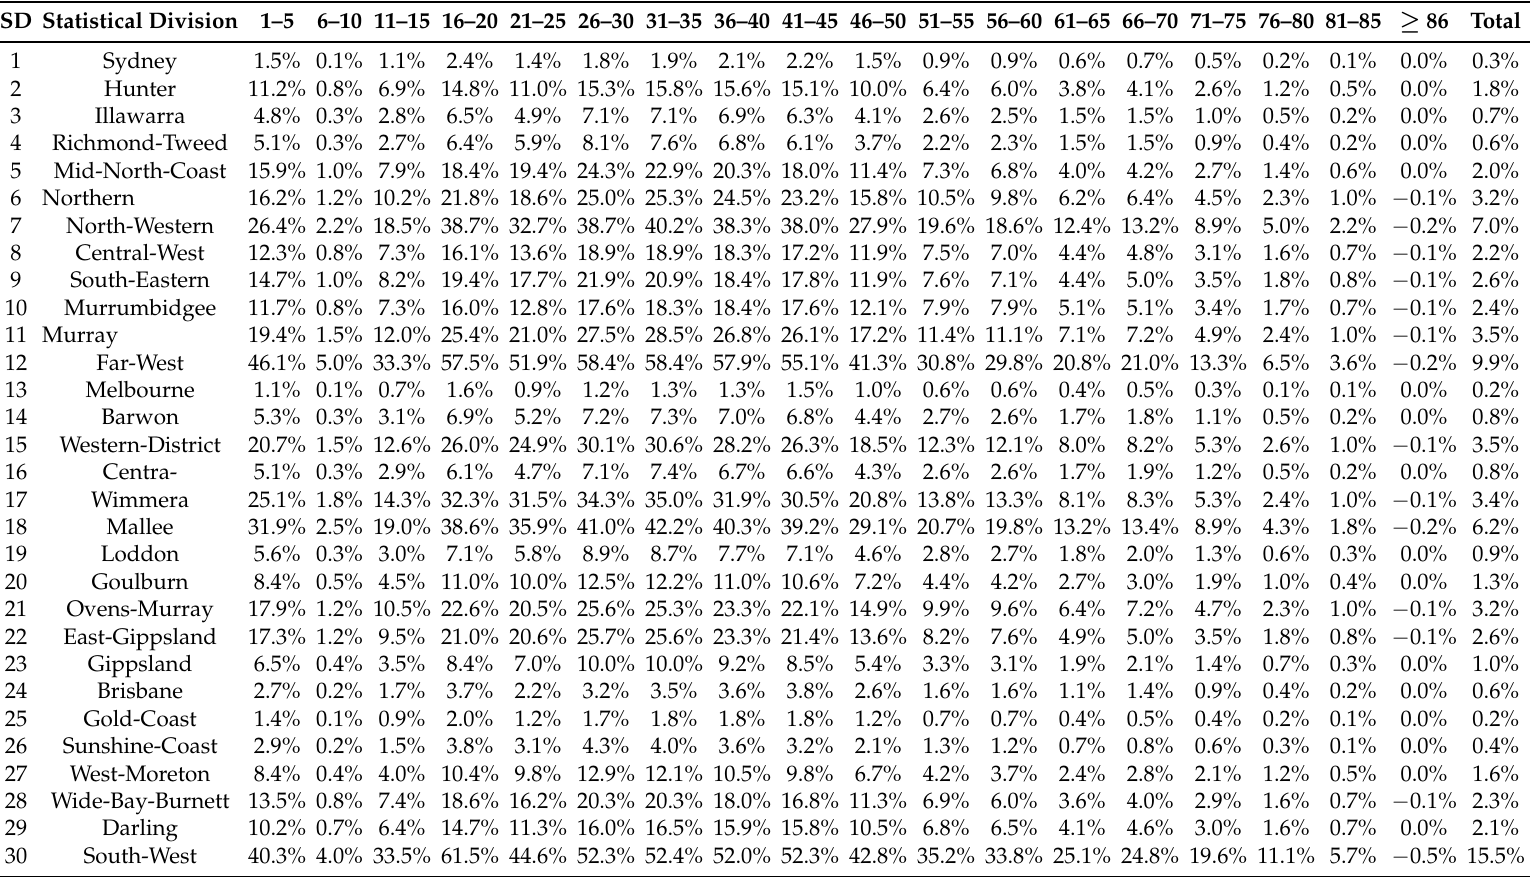
Table A2. Proximity